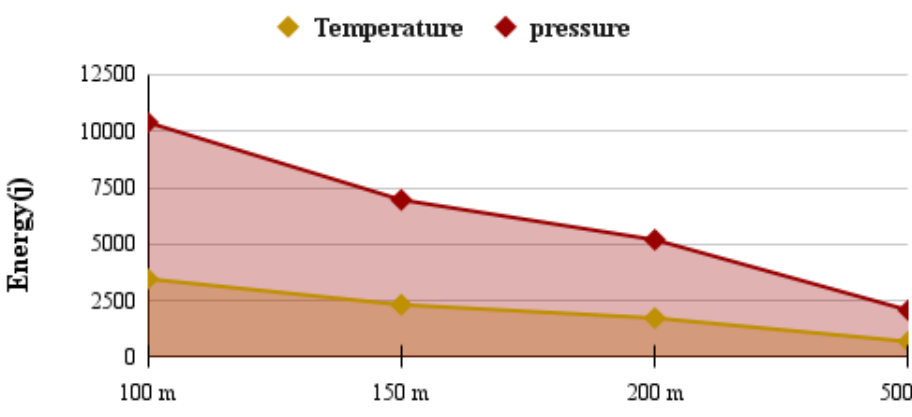
Figure 7. Energy for temperature and pressure sensors at different distances.